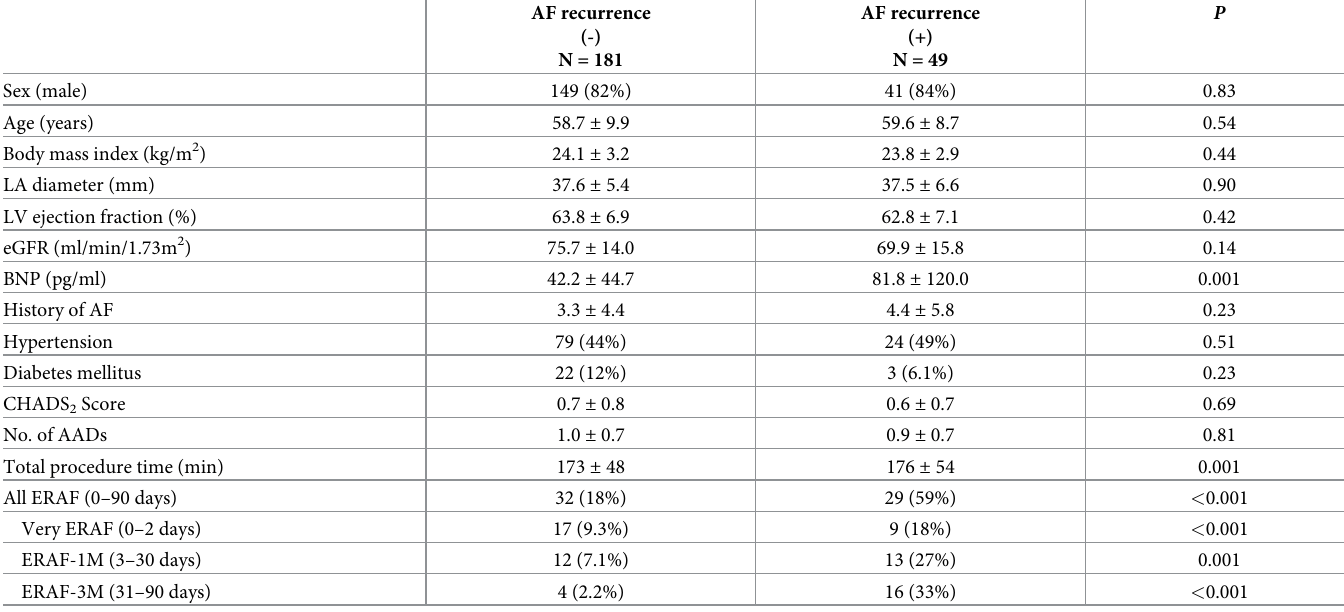
Table 5. Comparison between the patients with and without true AF recurrence after RF ablation.